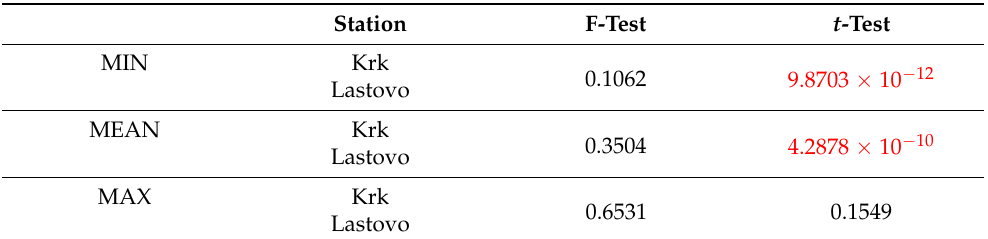
Table 2. Results of probability, p , of the F-test and t -test between minimum, mean, and maximum annual air temperatures on Krk and Lastovo (Figure 2). Station F-Test t -Test MIN Krk